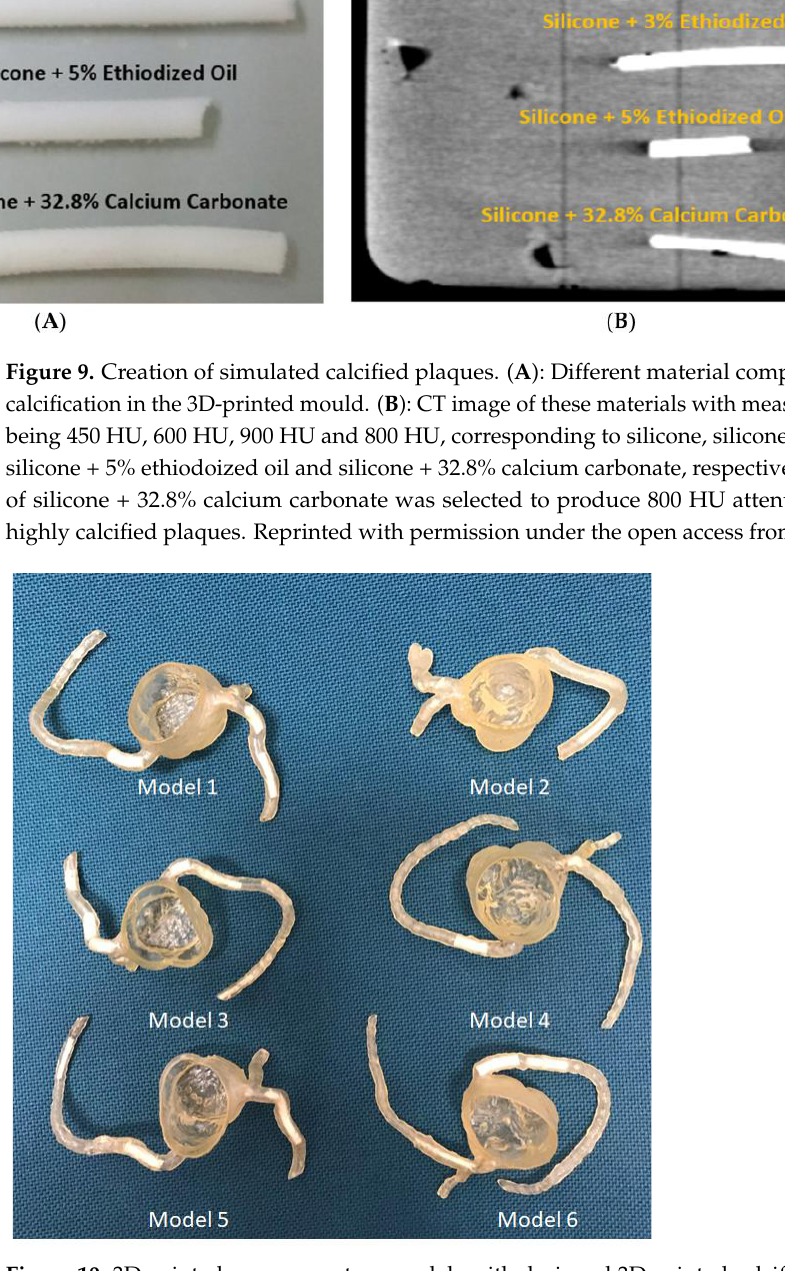
Figure 10. 3D-printed coronary artery models with designed 3D-printed calcified plaques inserted into the coronary artery branches to simulate high calcification. Reprinted with permission under the open access from Sun et al.